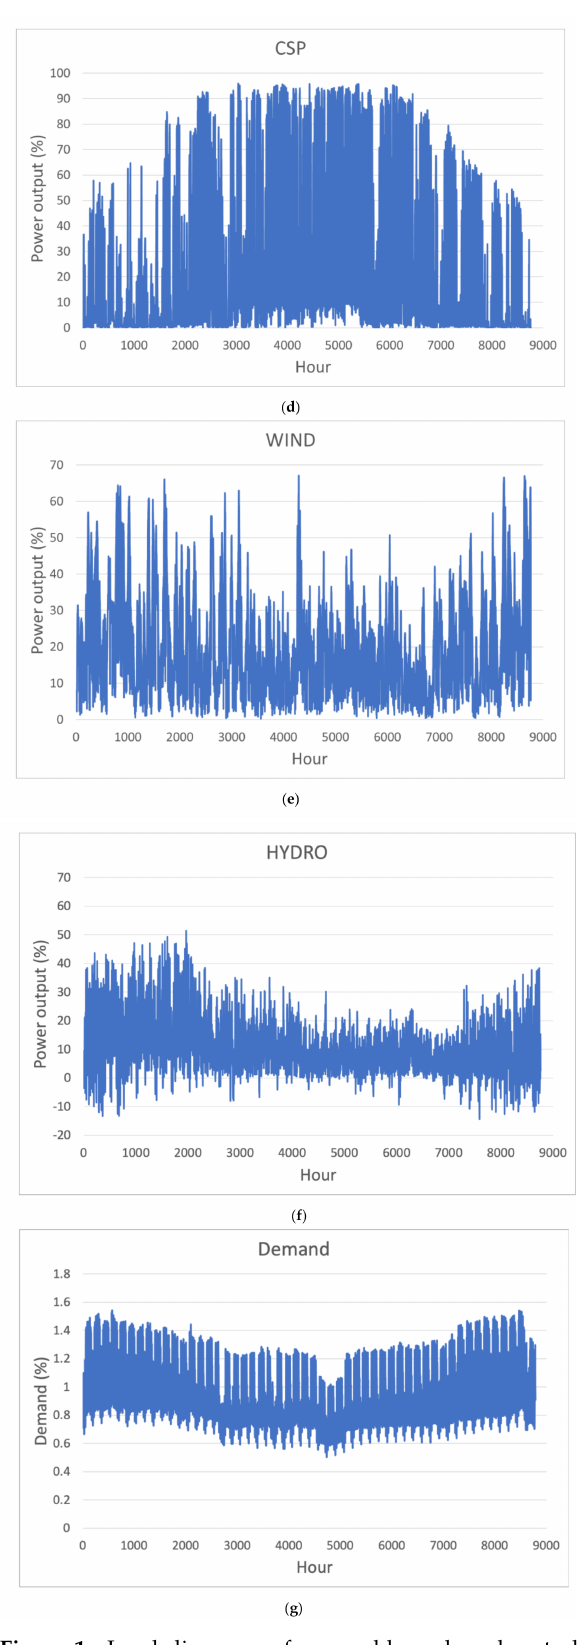
Figure 1. Load diagrams of renewable and nuclear technologies and demand diagram for the calibration with the model year 2017: ( a ) biomass; ( b ) nuclear; ( c ) photovoltaics; ( d ) Concentrating Solar Power; ( e ) wind; ( f ) hydro; ( g )